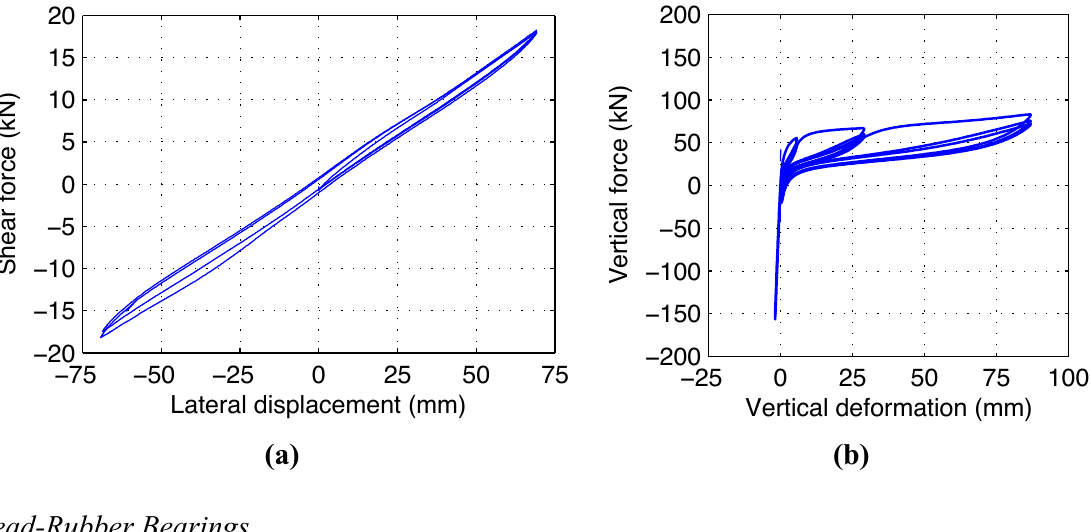
Figure 2. ( a ) Cyclic shear force-horizontal deformation response of low-damping natural rubber bearing; ( b ) Cyclic vertical force-deformation response of low-damping natural rubber